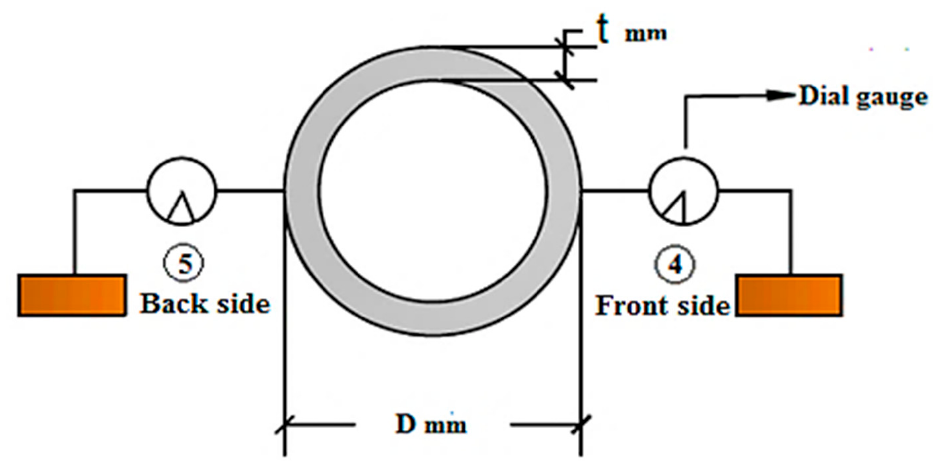
Figure 3. The dial gauges for measurement of the specimen ovalization.